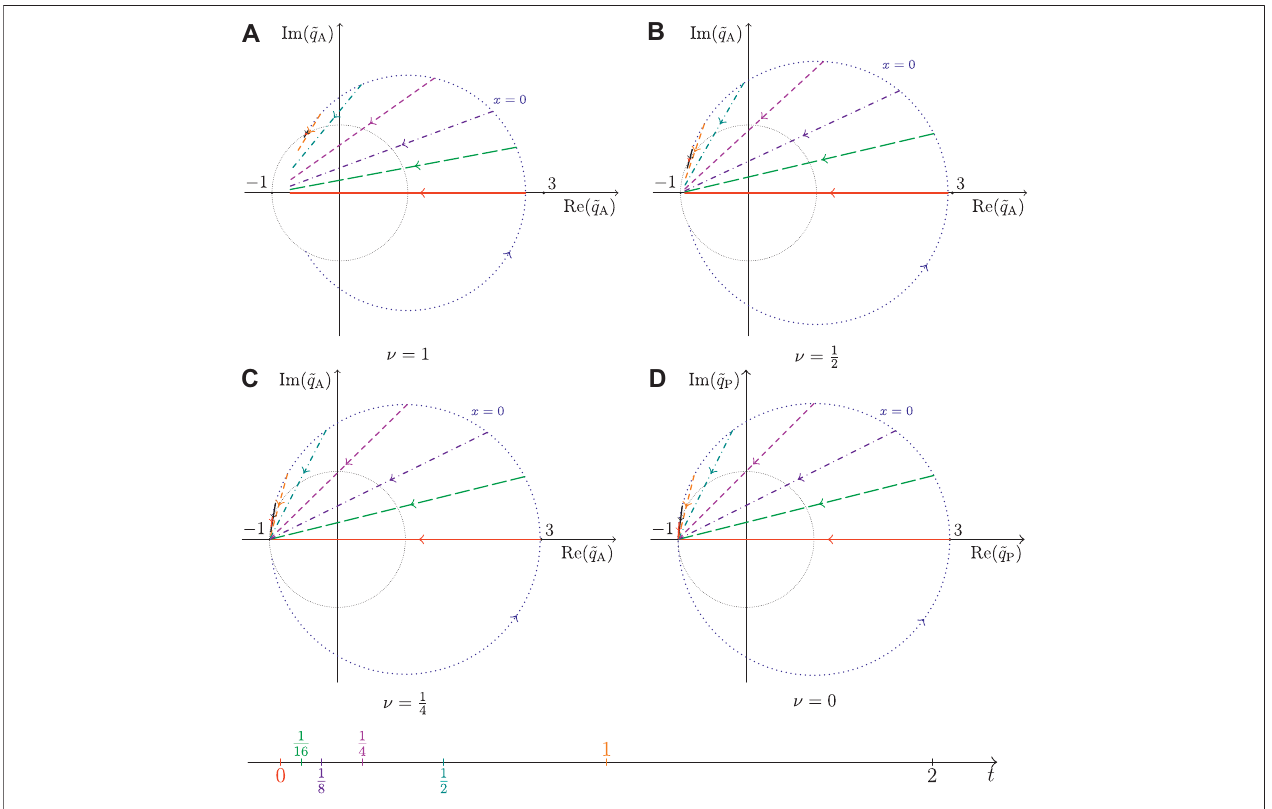
FIGURE 6 | Parameterizationofthenon-rapidoscillatingcomplex-valuedamplitude ~ q inthespatialvariable x for differentvaluesoftemporalvariable t : t (cid:2) 0 (solidred), t (cid:2) 1 / 16 (long-dashed green), t (cid:2) 1 / 8 (dash-dotted purple), t (cid:2) 1 / 4 (dash magenta), t (cid:2) 1 / 2 (dash-dotted cyan), t (cid:2) 1 (dashed orange), t (cid:2) 2 (solid black), and t (cid:2) 4 (solid red), and modulation frequencies of the Akhmediev solitons (A) ] (cid:2) 1 ( 0 ≤ x ≤ π ) , (B) ] (cid:2) 1 / 2 ( 0 ≤ x ≤ 2 π ) , (C) ] (cid:2) 1 / 4 ( 0 ≤ x ≤ 4 π ) , and (D) ] (cid:2) 0, x ≥ 0 (Peregrine